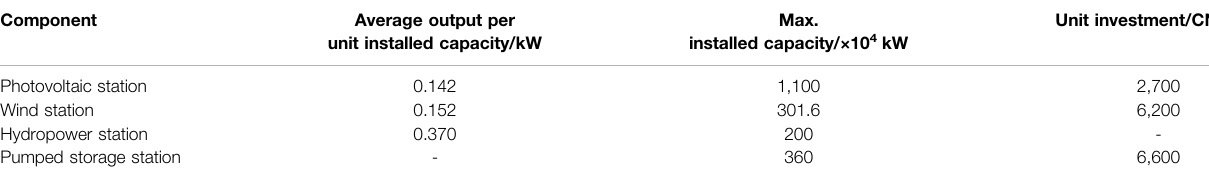
TABLE 3 | Overview of power supply of the multisource complementary energy base.